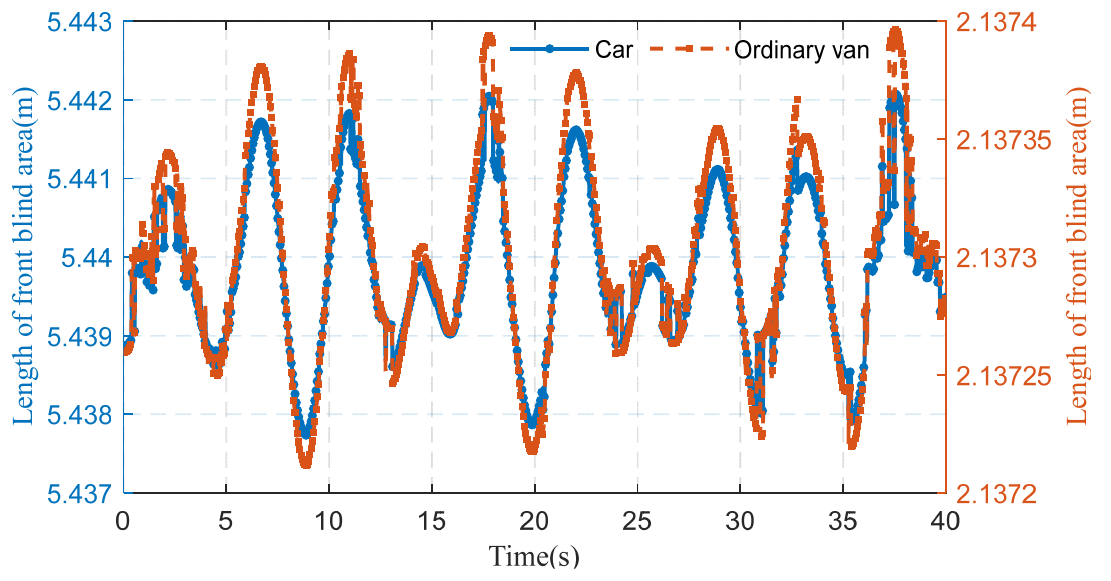
Figure 15. Online perception of front blind area for cars and ordinary vans. Different drivers drive the same vehicle, but the eye heights are different; therefore, the visual blind areas differ. When the driver sits comfortably, the eye height is lower, and